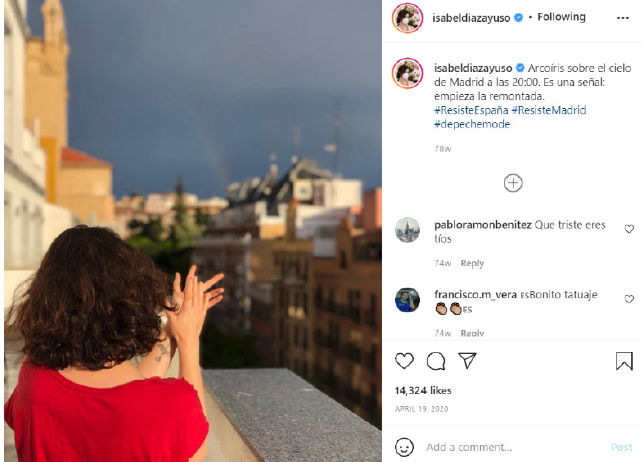
Figure 1. Díaz Ayuso clapping from a hotel room after testing positive for Covid‐19 on April 19, 2020. around. Clapping to the rhythm of Depeche Mode, she